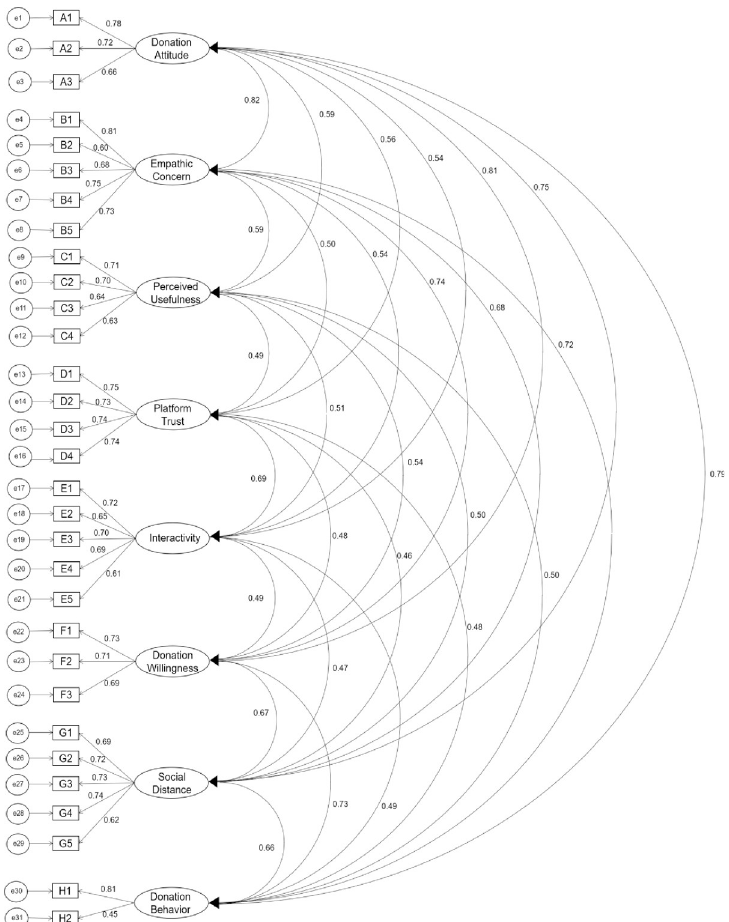
Fig 3. Confirmatory factor